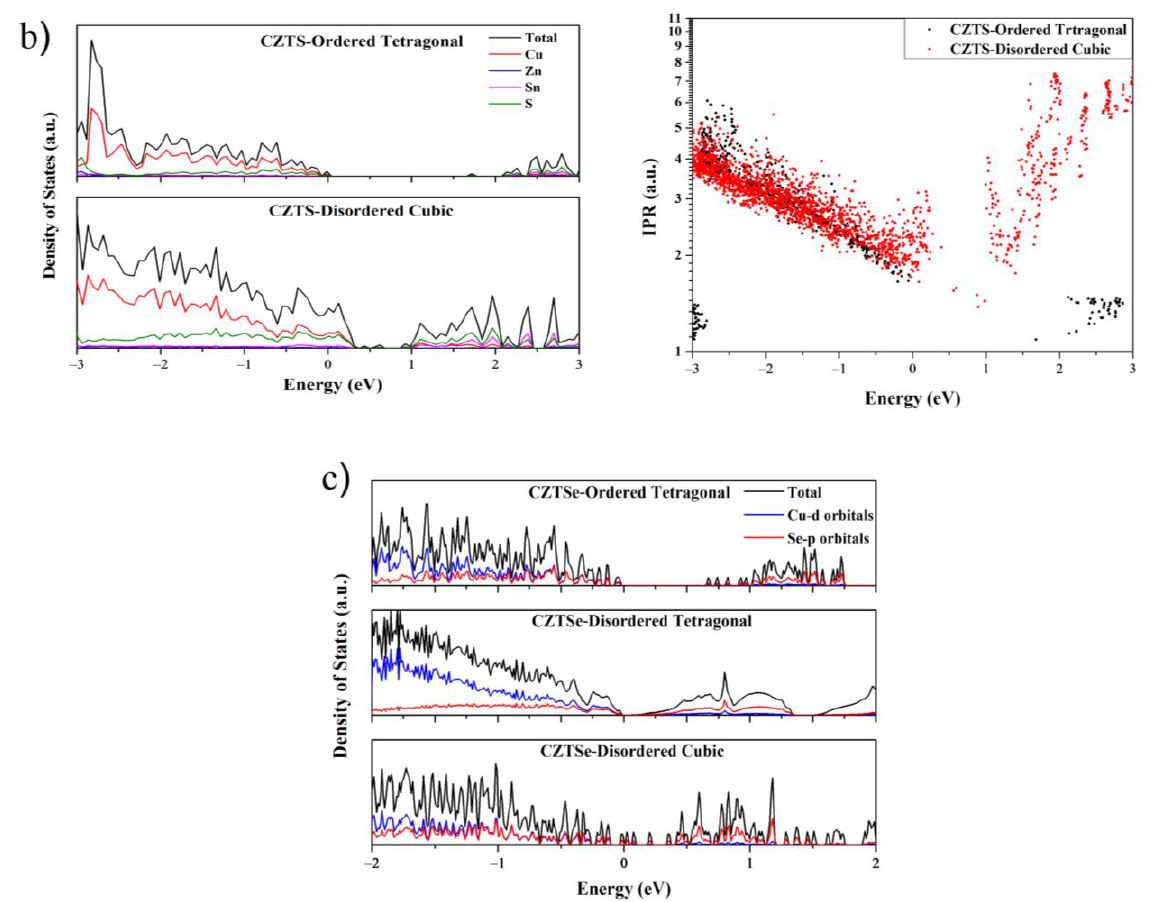
Figure 5. The total and atomic projected electronic density of states for CTS ordered monoclinic, CTS Disordered Cubic 1 (Cu-21, Sn-11, S-32), and CTS Disordered Cubic 2 (Cu-22, Sn-10, S-32) ( a ), CZTS ( b ), and CZTSe ( c ) polymorphs. Here, the Fermi level is set to zero. The IPR for the CTS and CZTS shows localized states near the Fermi level.